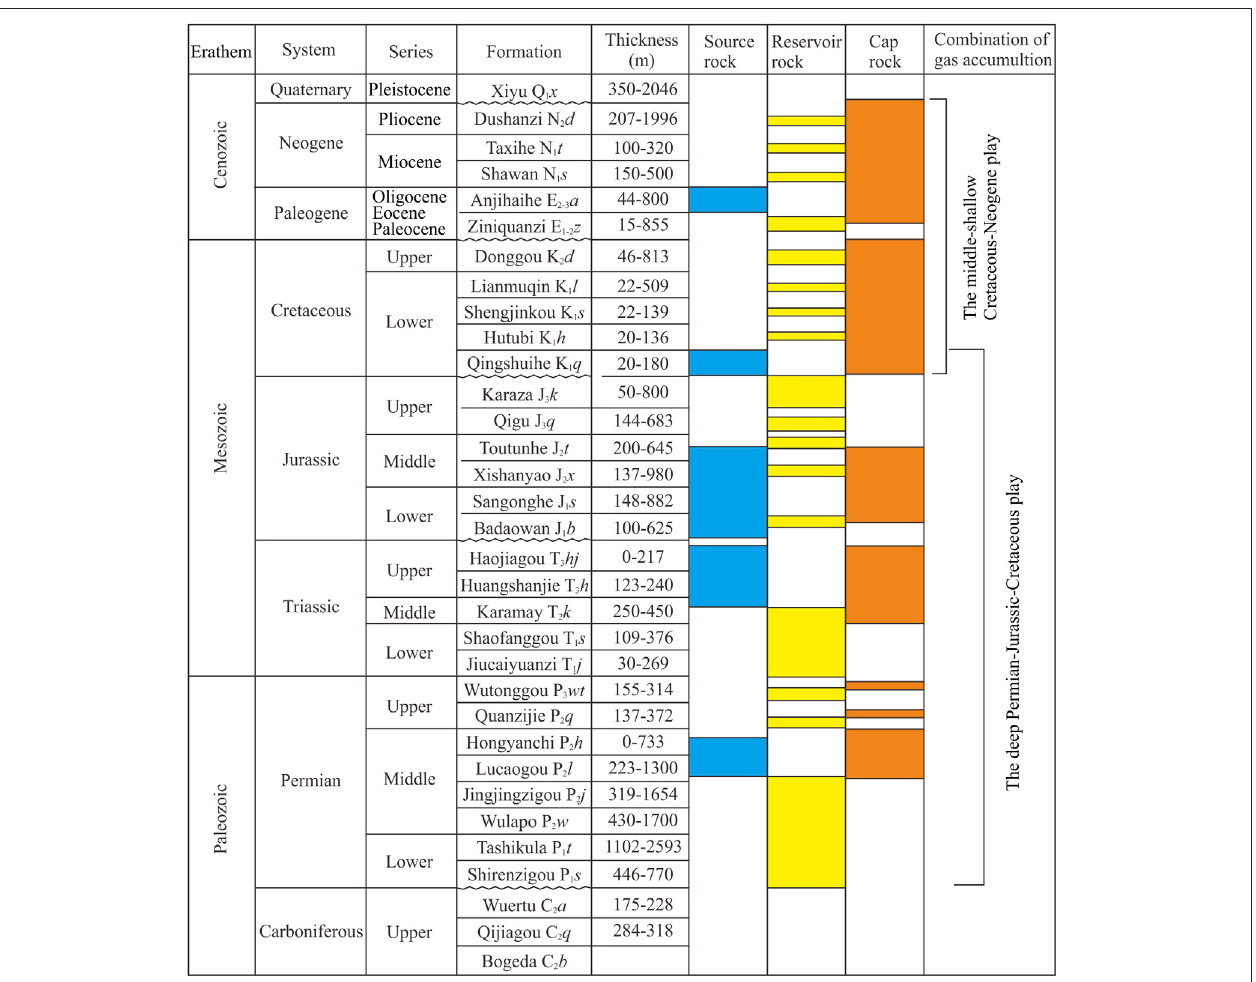
Frontiers in Earth Science |